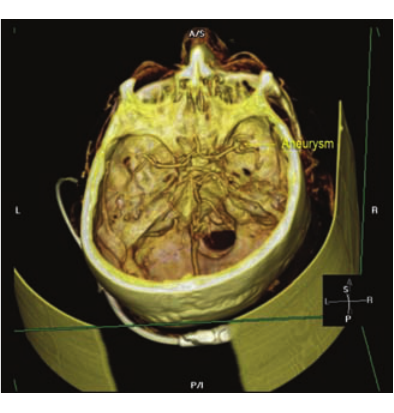
Figure 7. Computed tomography angiog- raphy showing an 8 x 5 mm aneurysm involving the junction of the M1 and M2 segments of the right middle cerebral